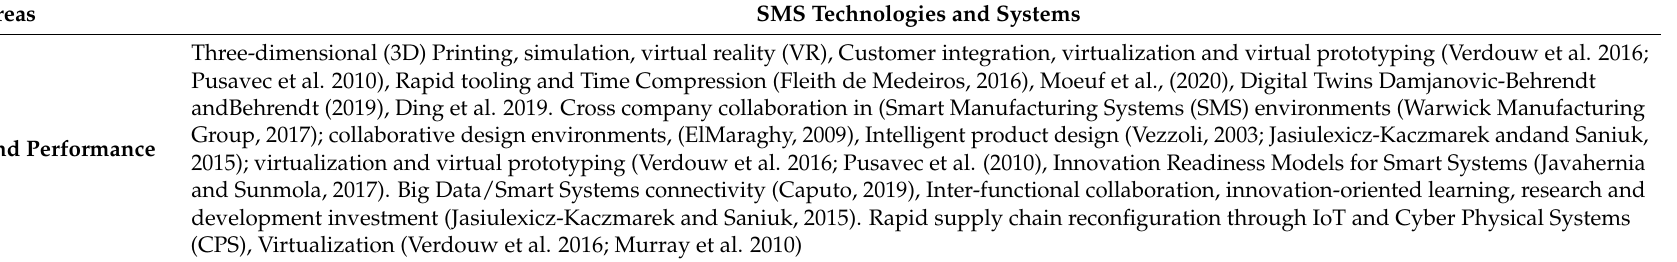
Table 1. An analysis of the literature on smart technologies and management